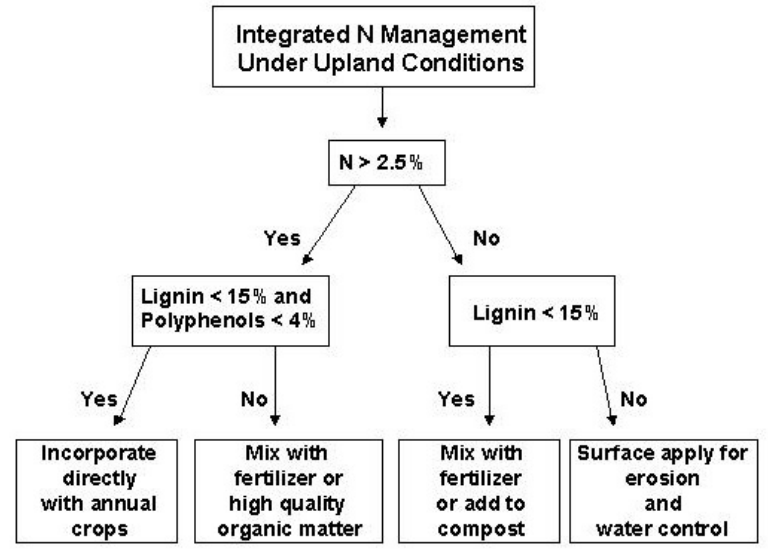
FIGURE 1 . A decision tree on the use of organic resources for integrated nutrient management[18].